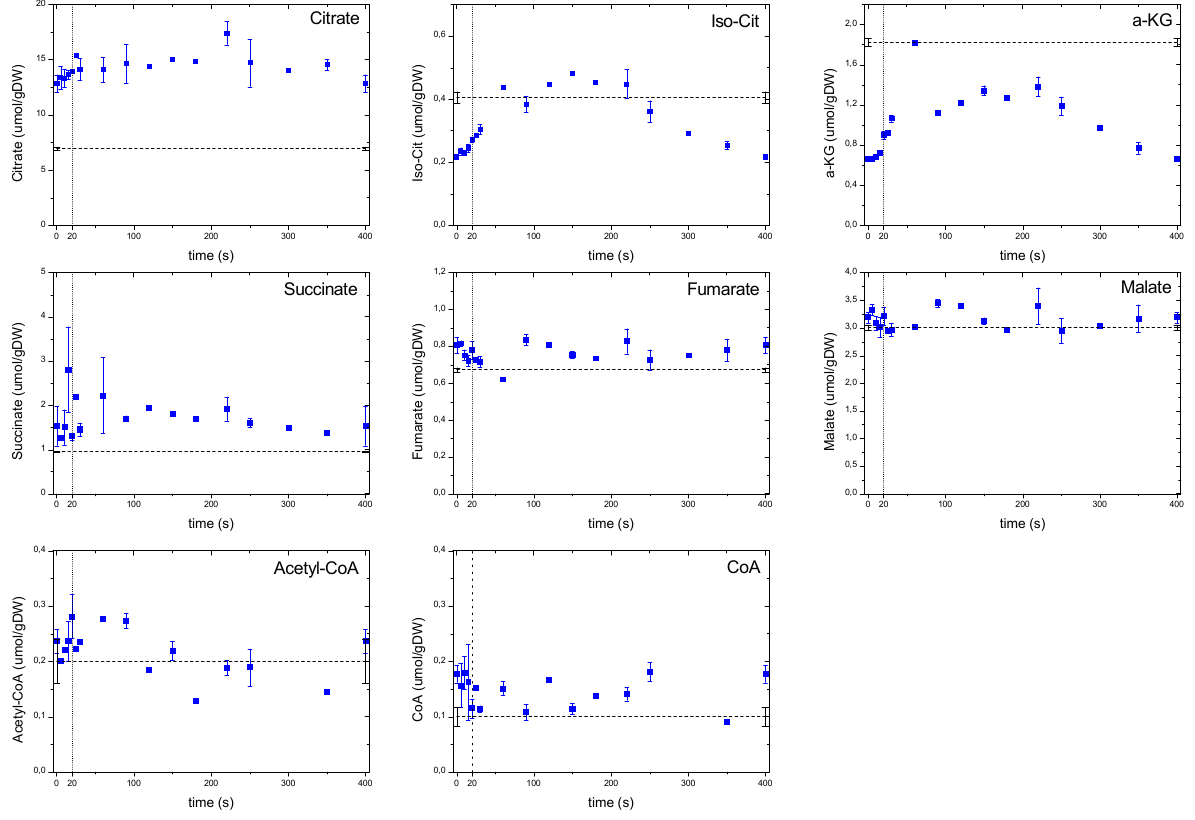
Figure 8. Concentration measurements of the TCA metabolites during the feast/famine cycle. The dashed line represents the reference steady-state (D = 0.1 h − 1 ), error bars represent the standard error of duplicate determination during two subsequent cycles. The vertical dotted line represents the end of the feeding